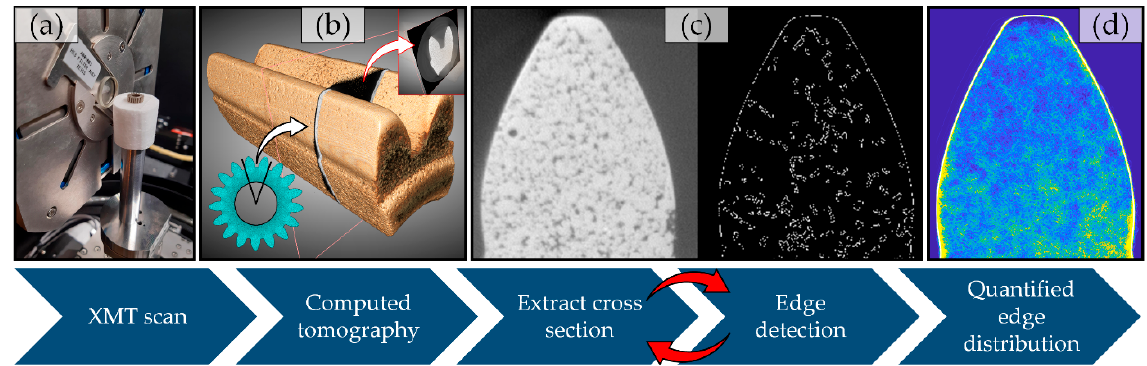
Figure 5. Method for subsurface analysis by X-ray microtomography (XMT). ( a ) Gear placed on rotary sample holder to be scanned by XMT. ( b ) 3D representation of gear section created by computed tomography. ( c ) Tomographic images perpendicular to axial dimension of gear extracted, and analyzed by edge detection algorithm. ( d ) Edge distribution quantified by summation of detected